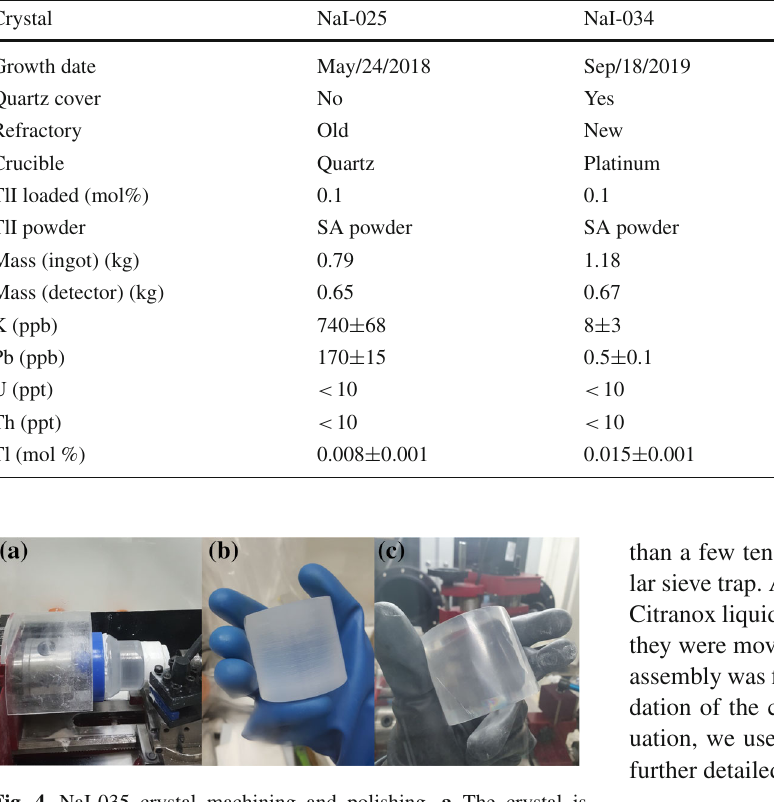
polished detectors. The lower five entries list the ICP-MS results of the grown crystals, where top and bottom measurements are averaged and uncertainties are half the differences of the two measurements